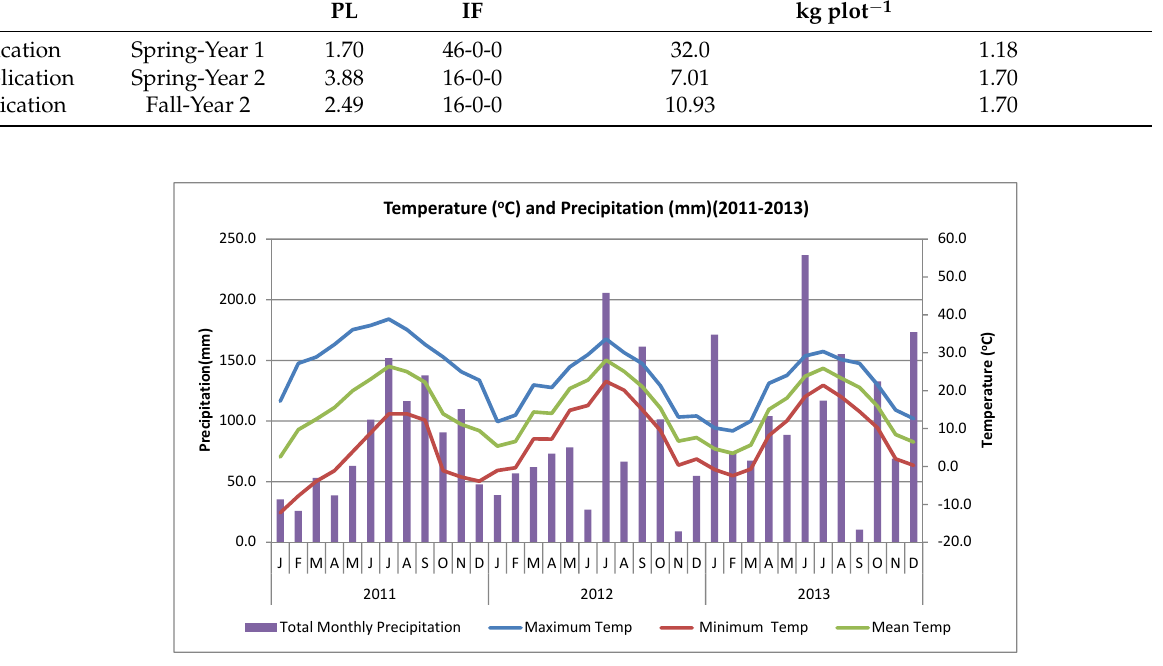
Figure 1. Monthly precipitation (mm) and temperature (°C) records of the experimental region during the study and growing seasons from 2011–2013 (usclimatedata.com). Table 1. Initial experimental plot analysis for soil and poultry litter.